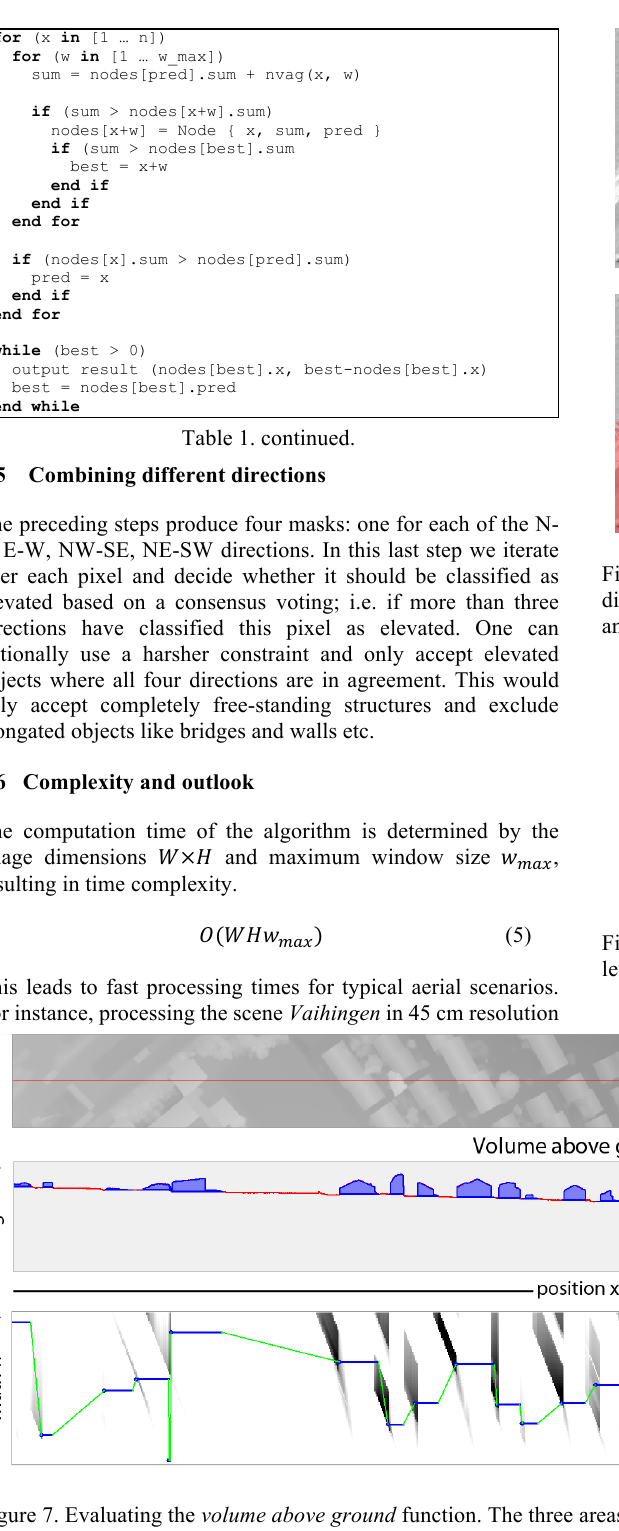
Figure 7. Evaluating the volume above ground function. The three areas of the diagram show, top to